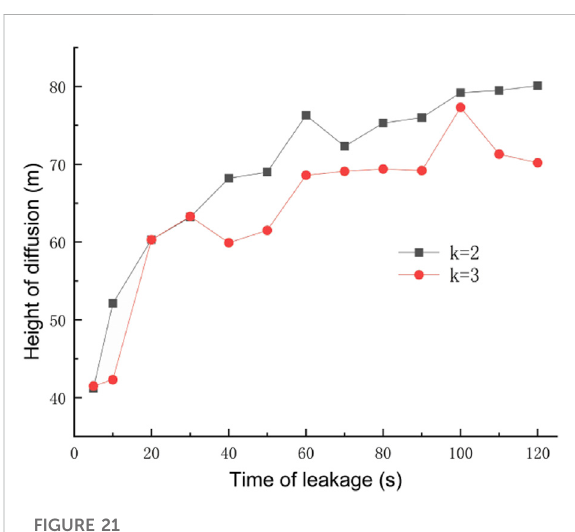
Figure 18. The dispersion heights of different obstacle distances at different times are shown in Figure 19.